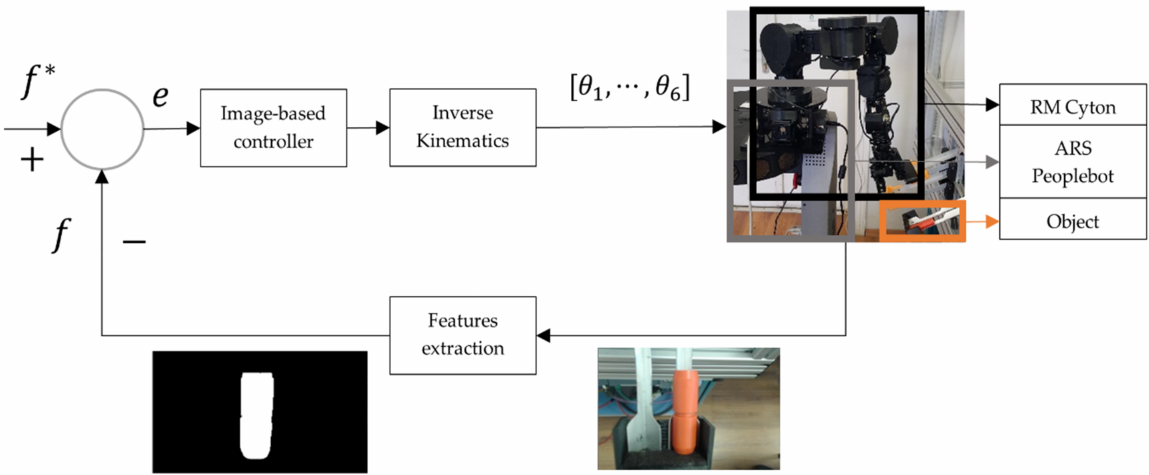
Figure 13. Closed-loop control of the RM Cyton based on eye-in-hand type